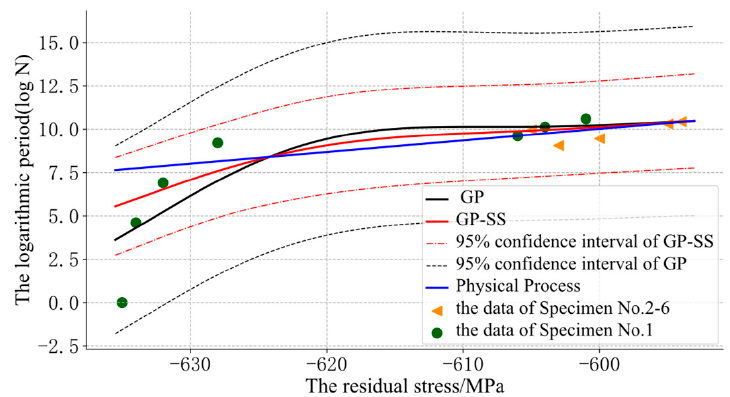
Figure 9. The results of different models for specimen